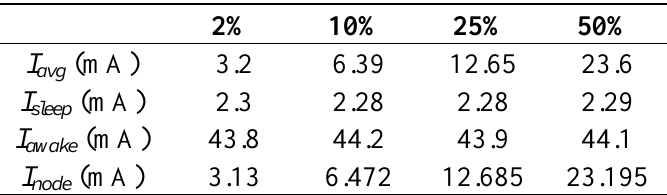
Table 3. Current consumption at sleep and wake up state for different duty-cycle rates (CC2420 radio